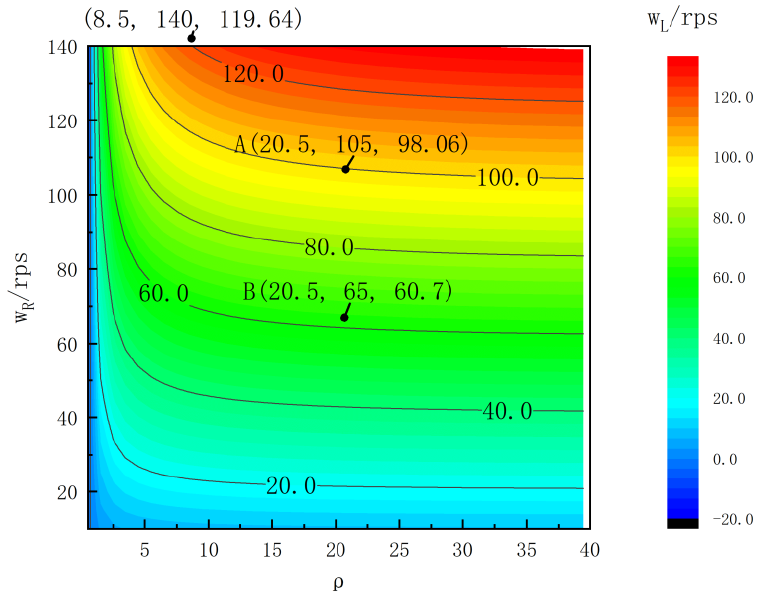
Figure 6. Motor contour curve under cement road.